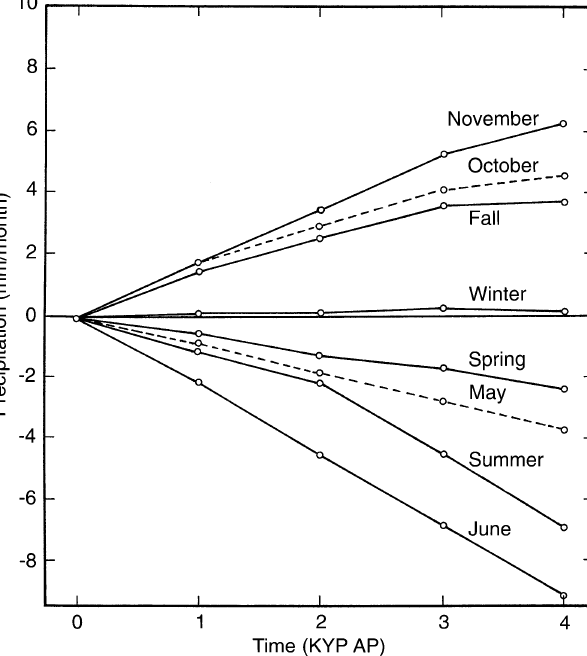
Fig. 9. Average values of the precipitation anomalies due to orbital variations from present to 4 kyears AP, in mm per